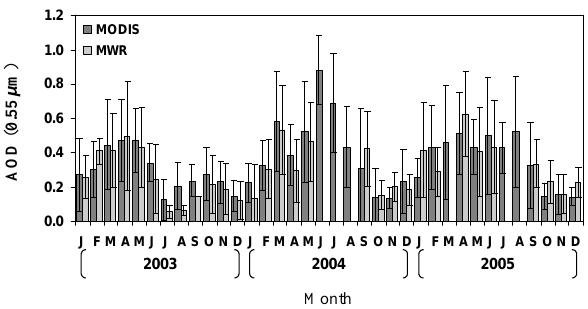
y = 0.79x + 0.07 R 2 = 0.72 Fig. 8. Scatter plot between AOD derived from MODIS and MWR during the year 2003 to 2005 over Dibrugarh.